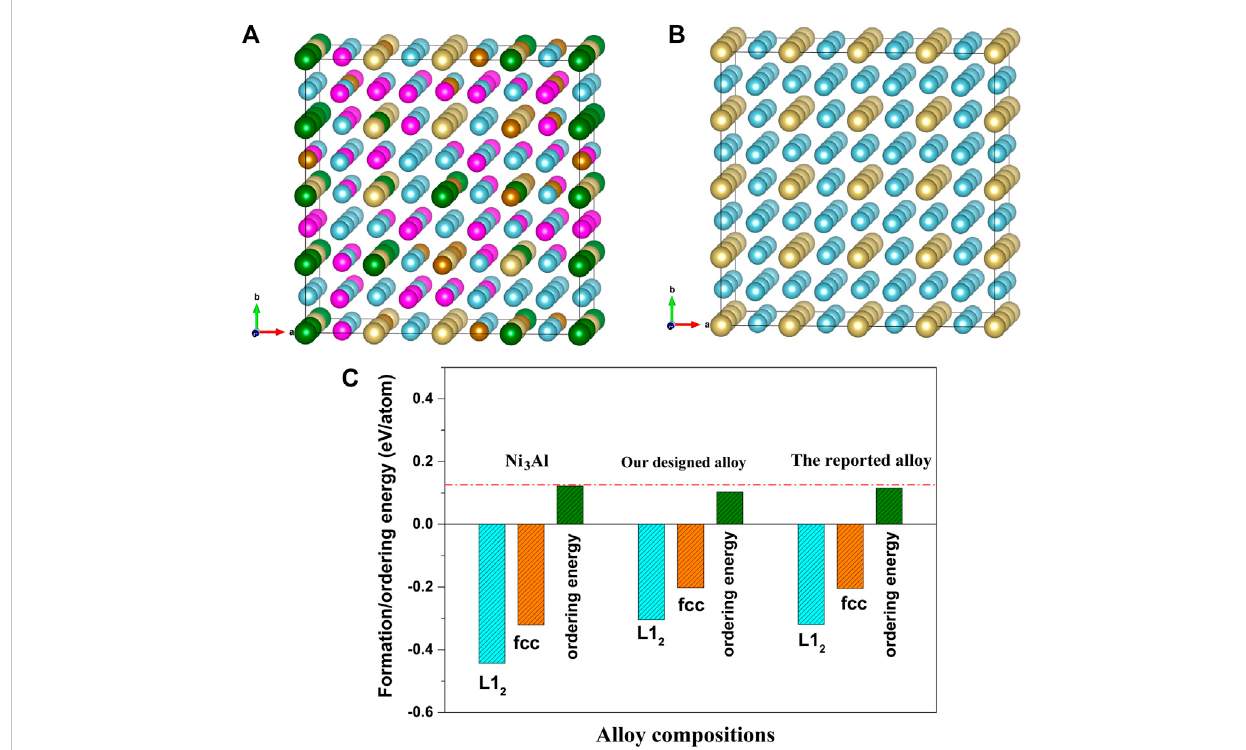
FIGURE 4 Supercell structures for the (A) multicomponent and (B) binary L1 2 lattice determined by DFT calculations. (C) Calculated formation energies of the L1 2 and fcc structures, as well as the corresponding ordering energy of Ni 3 Al, our studied multicomponent L1 2 alloy, and the previously reported